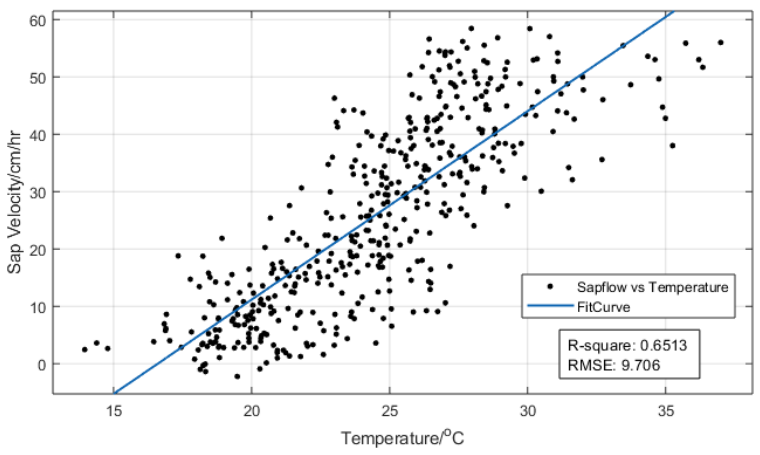
Figure 6. The linear fit between the sap flow rate and canopy temperature.